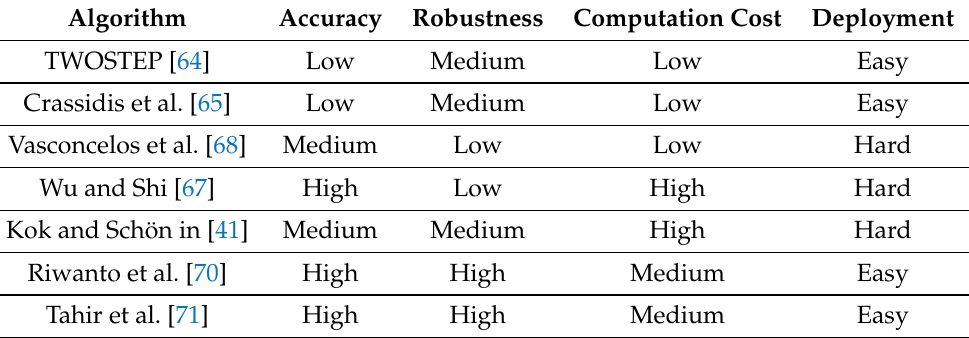
Table 3. Comparison of calibration